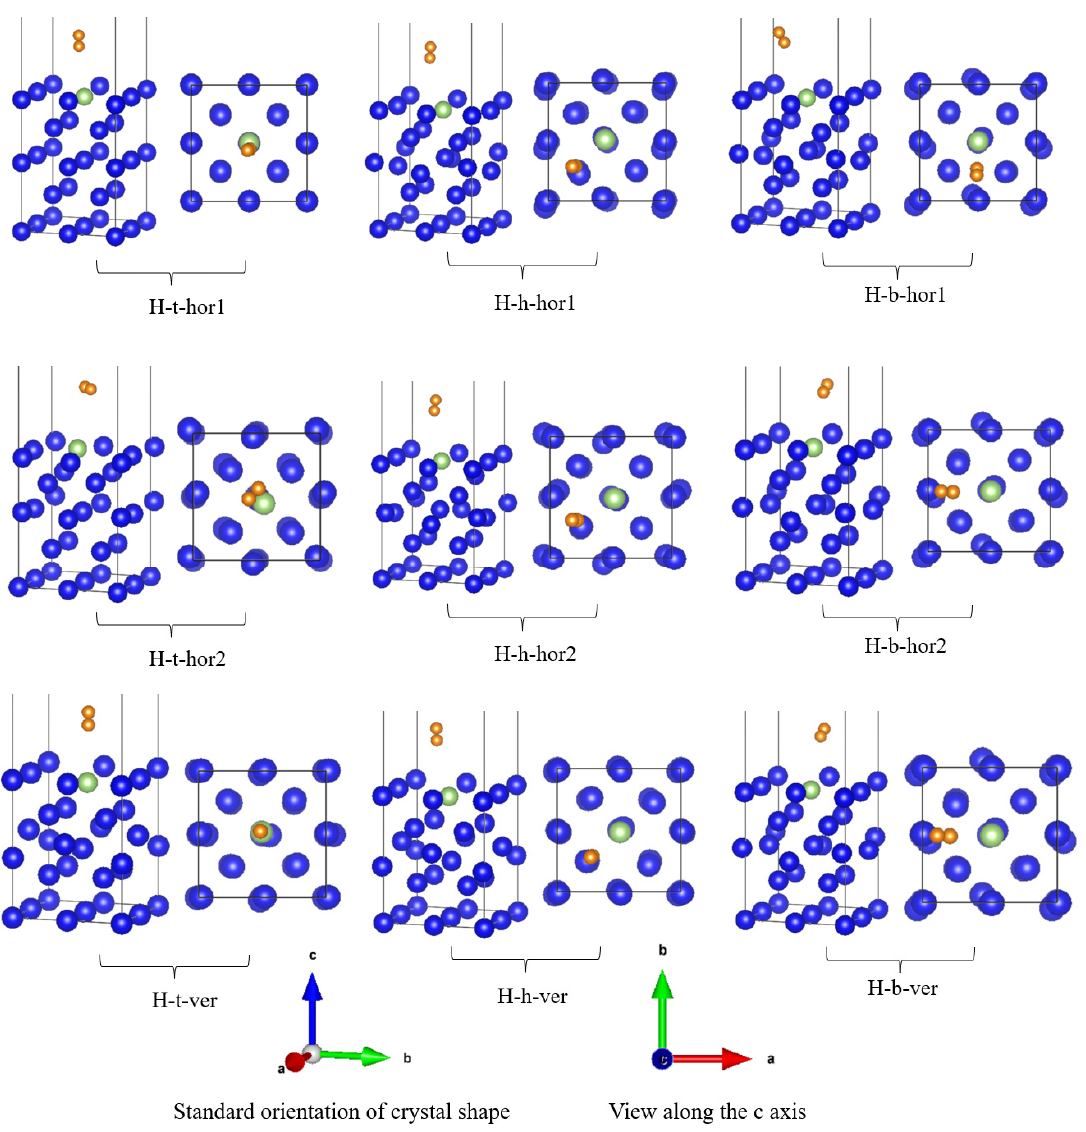
Figure 3. Stable adsorption configurations of H 2 on the surface of plutonium–gallium system after optimization (for each configuration, the standard view is on the left and the c-axis view is on the right). H: hydrogen molecule; t: top position; h: hollow position; b: bridge position. Table 1. Structural parameters and energy data of the adsorption configuration of H 2 on the surface